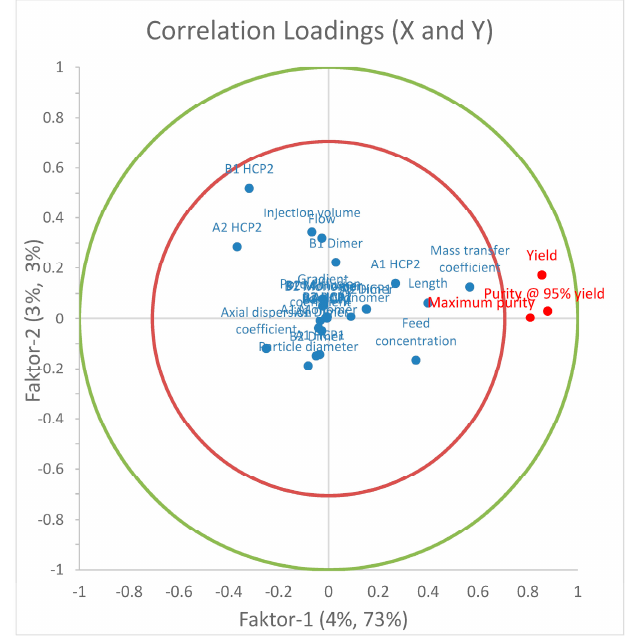
Figure 7. Correlation loadings plot visualizing the dependencies between each variable as found for the Monte Carlo simulations.